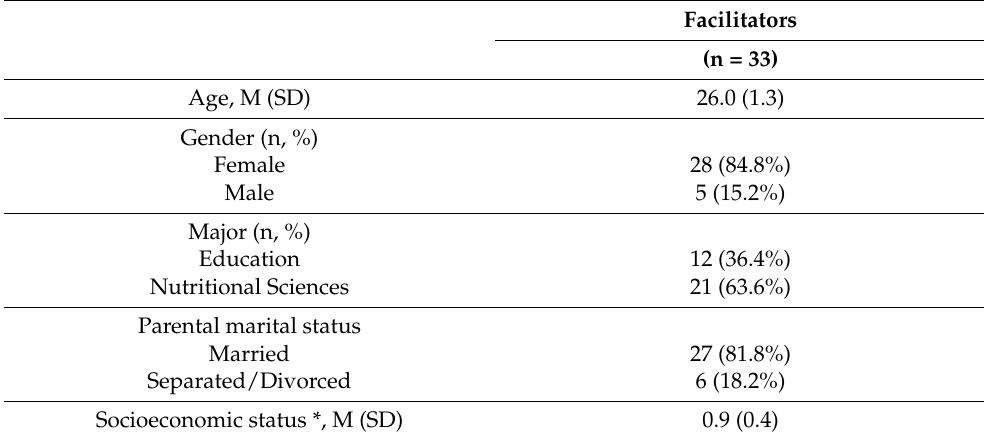
Table 1. Descriptive characteristics of